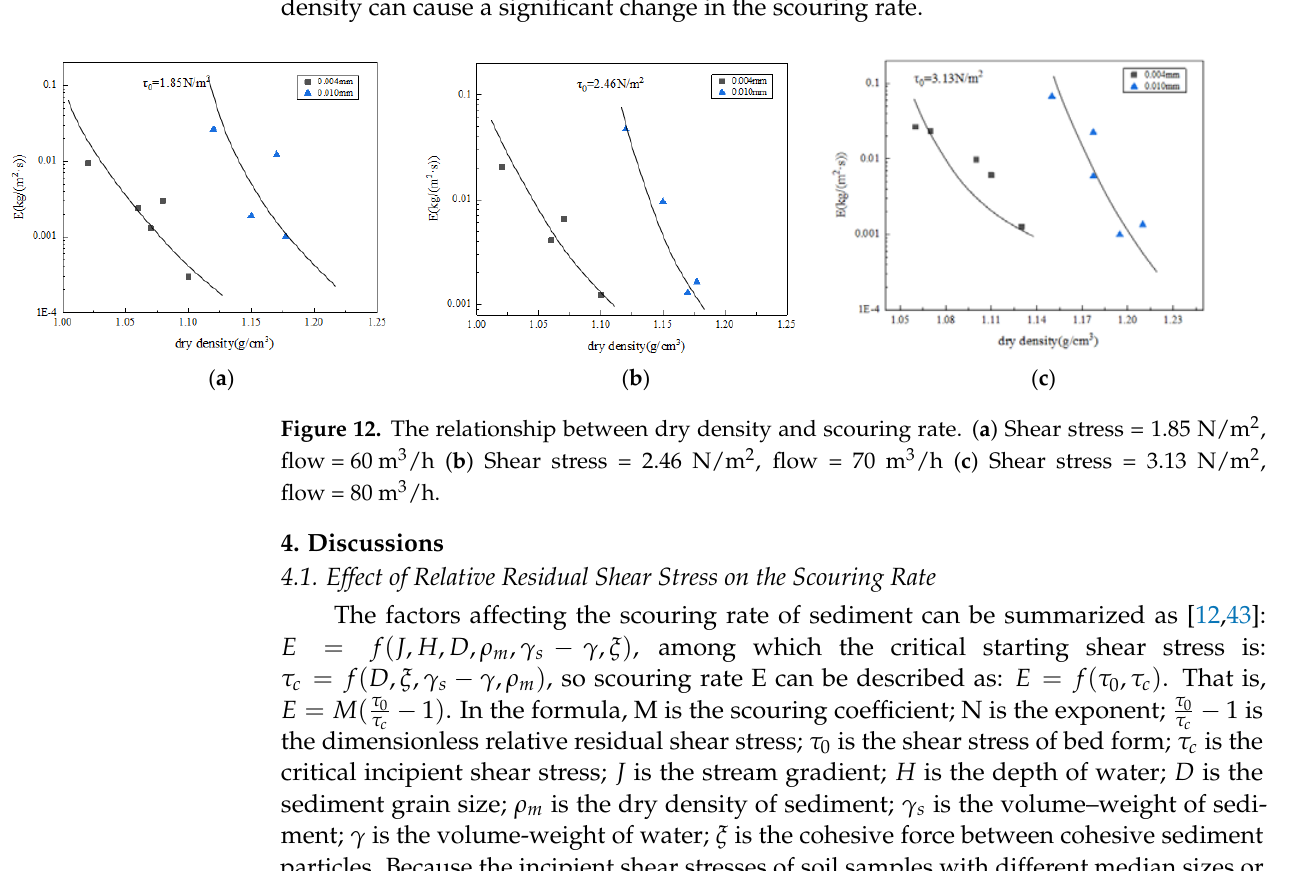
( b ) Figure 11. The relationship between water content and scouring rate. ( a ) D 50 = 0.004 mm ( b ) D 50 = 0.01 mm.